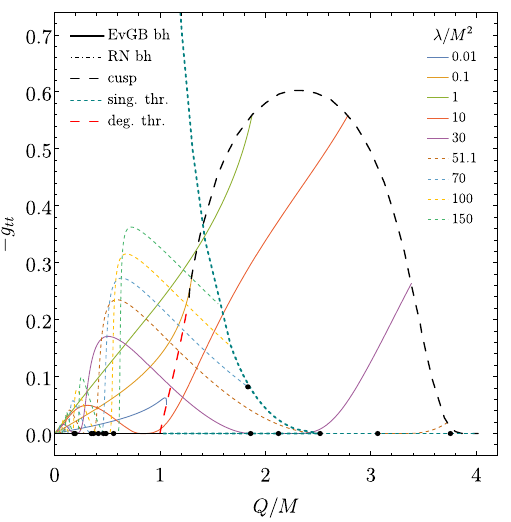
Fig. 15 − g tt atthethroatvs.scaledvectorchargeforcouplingfunction (i). Analogous to Fig. 11